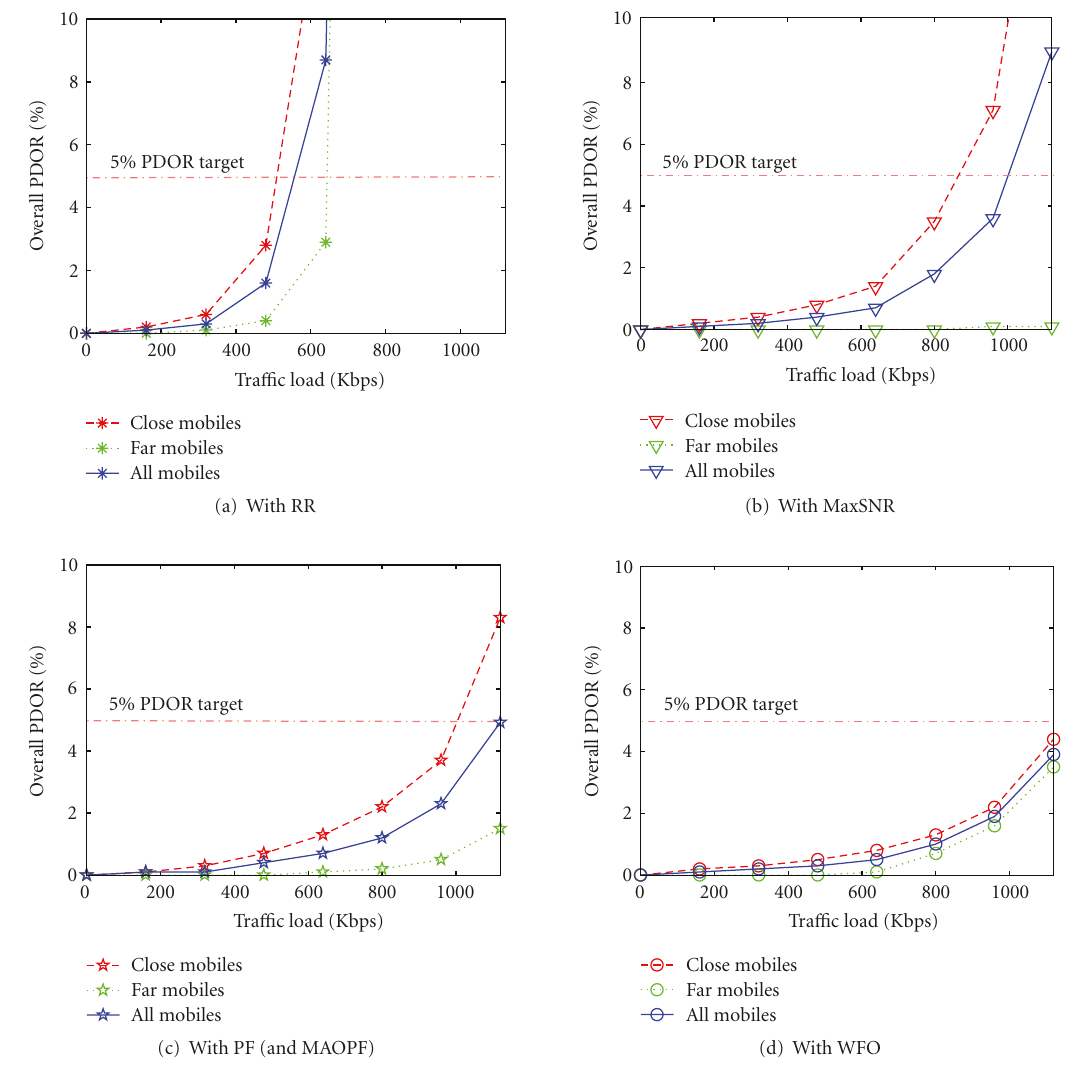
Figure 7: Measured QoS with respect to distance.